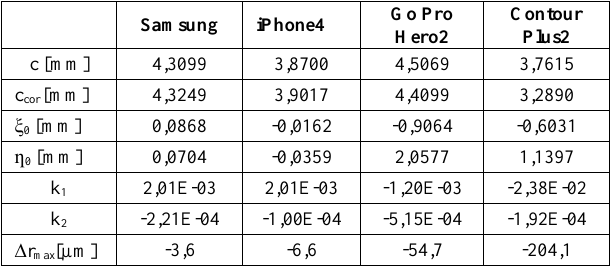
Table 2 - The calibration results